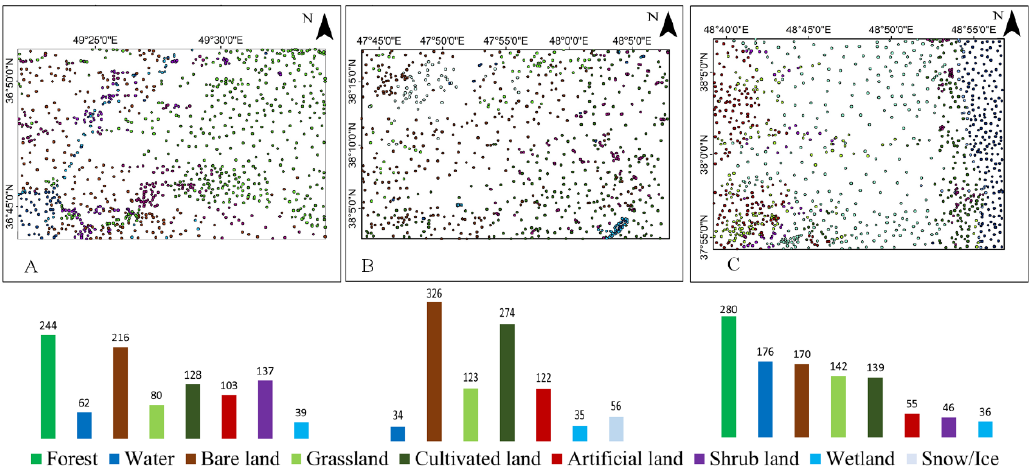
Figure 3. Left and right columns, respectively, show the number of the generated reference samples for each land cover class and their spatial distributions over each experiment site (( A ) Site-1, ( B ) Site- 2, and ( C )